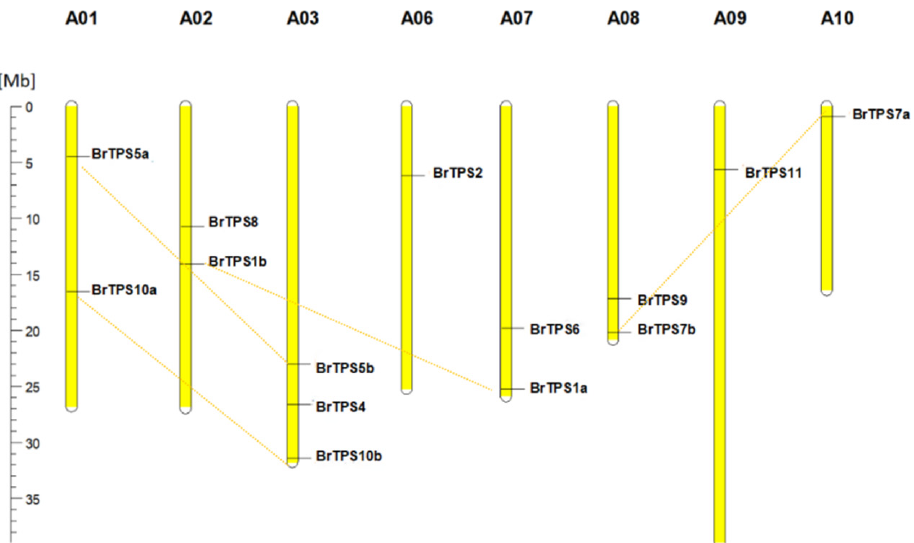
Figure 5. The TPS gene locations in B. rapa chromosomes. The chromosomes are represented by yellow bars. The chromosomal position of each BrTPS gene was mapped according to the B. rapa genome. The chromosome number is indicated at the top of each chromosome. The scale is in megabases (Mb).